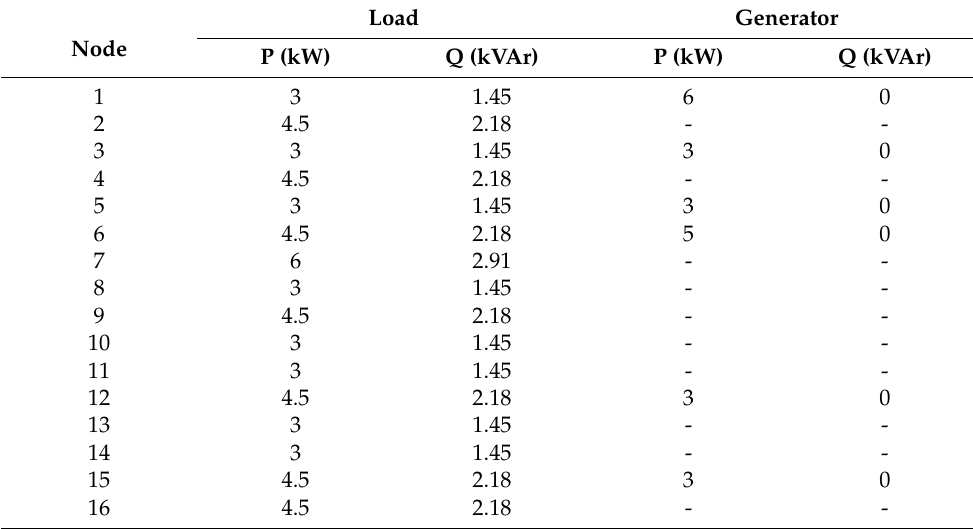
Figure 7. The RTDS low-voltage network. Table 1. Load and generation